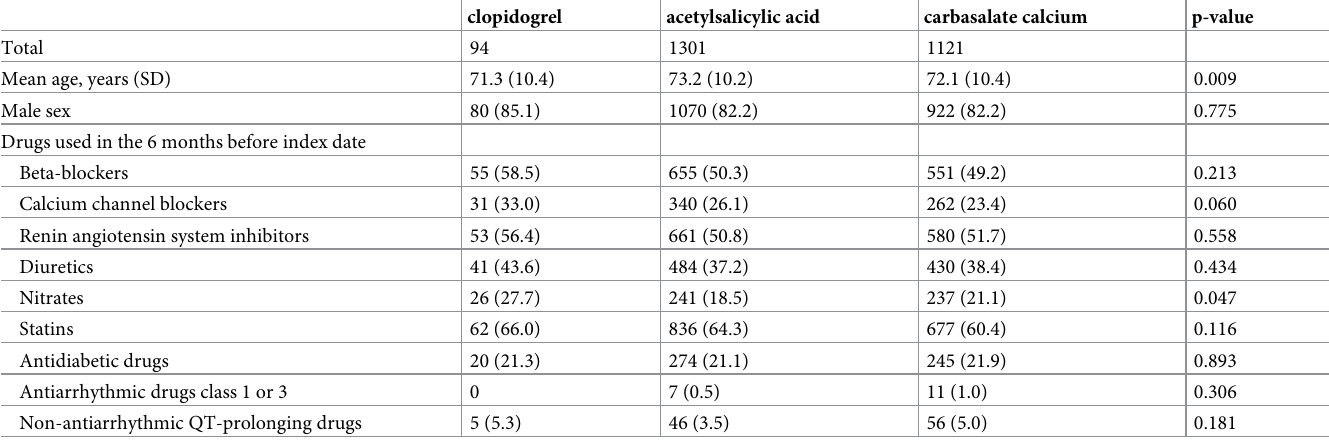
Table 2. Characteristics of clopidogrel, acetylsalicylic acid and carbasalate calcium users. clopidogrel acetylsalicylic acid carbasalate calcium